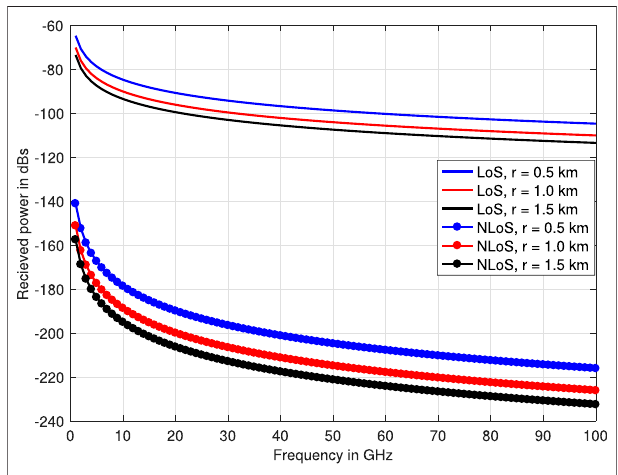
FIGURE 4 | Received power with respect to operating frequency and